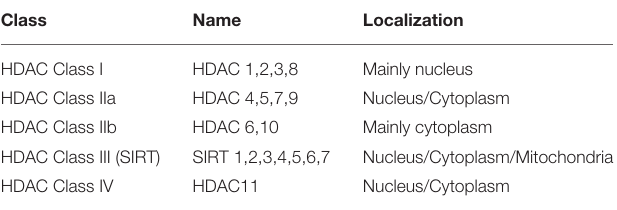
TABLE 1 | Classification of histone deacetylase